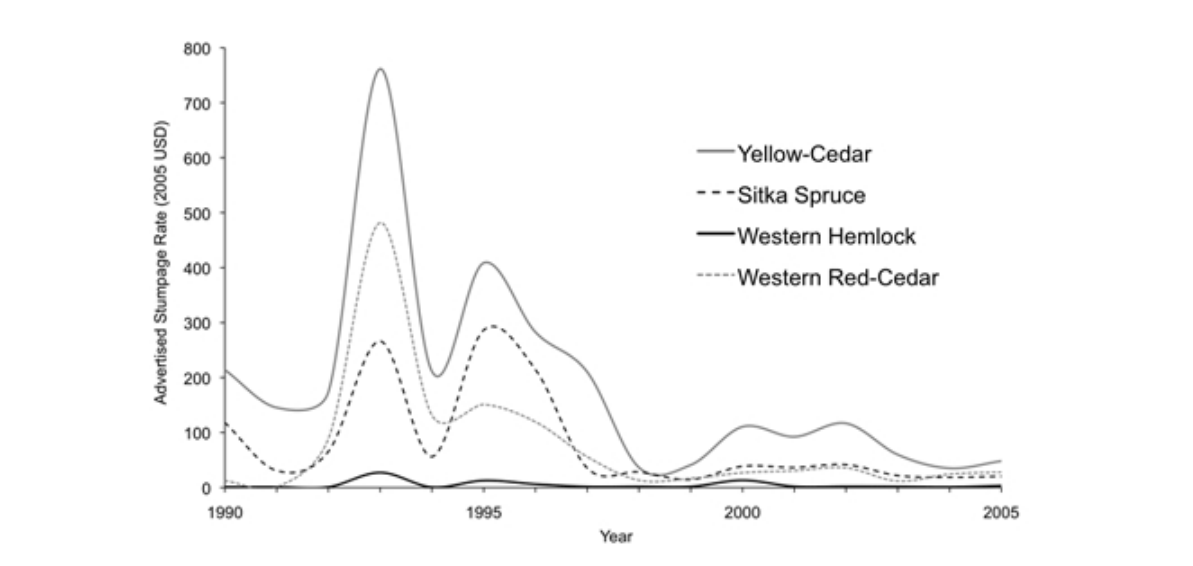
Fig. 4 . Mean advertised value of stumpage by species in Tongass National Forest timber sales from 1990-2005, in USD (not adjusted for